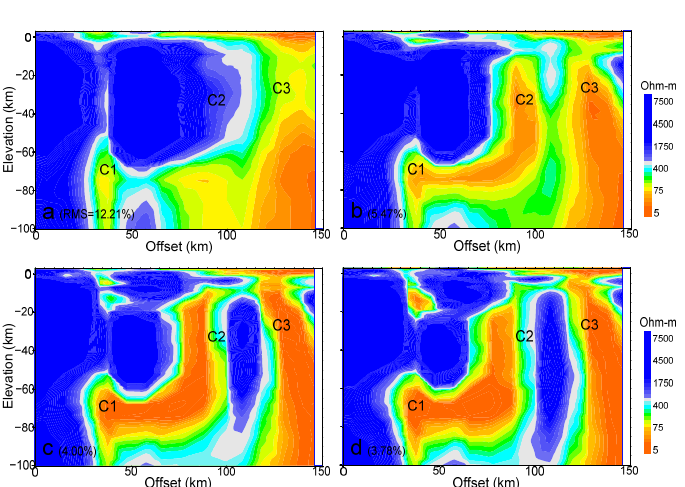
Figure A1. NLGG inversion result with different iterations. ( a ) is the result of 1 iteration, ( b – d ) is those of 11, 31, and 53, respectively.